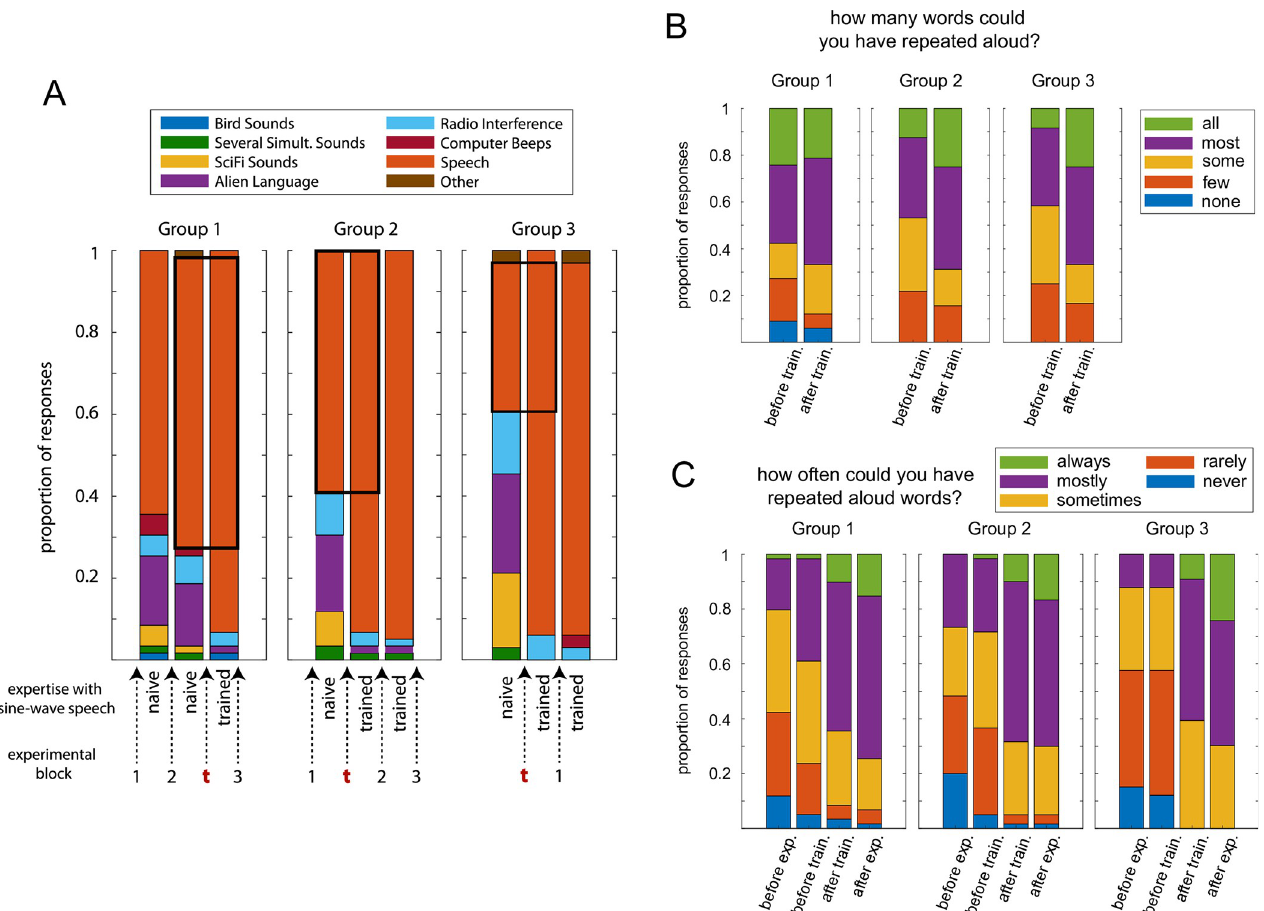
Fig 5. Testing the perception of sine-wave speech throughout the experiment. A. Proportion of responses given in the three different groups when asked to describe the sine-wave speech (multiple-choice stimulus description task; see Experiment 3, Procedure). Note that all groups completed this questionnaire before and after training and, in addition, after the second (Group 2) or first experimental block (Groups 1 and 3). All groups therefore completed three questionnaires, even though Group 3 only completed one experimental block. The bottom part shows the experimental course with training (t), the experimental blocks, and assumed expertise with sine-wave speech. B. Proportion of responses to the question “How many words could you have repeated aloud?”, presented immediately after participants selected “speech” in the stimulus description task. Only data from participants is shown whose response was “speech” both before and after training in A (black squares). C. Proportion of responses to the question “How often could you have repeated aloud words from the speech you heard?”, answered by all participants after the experiment, retrospectively about various points during the experiment (intelligibility frequency rating; see Experiment 3,